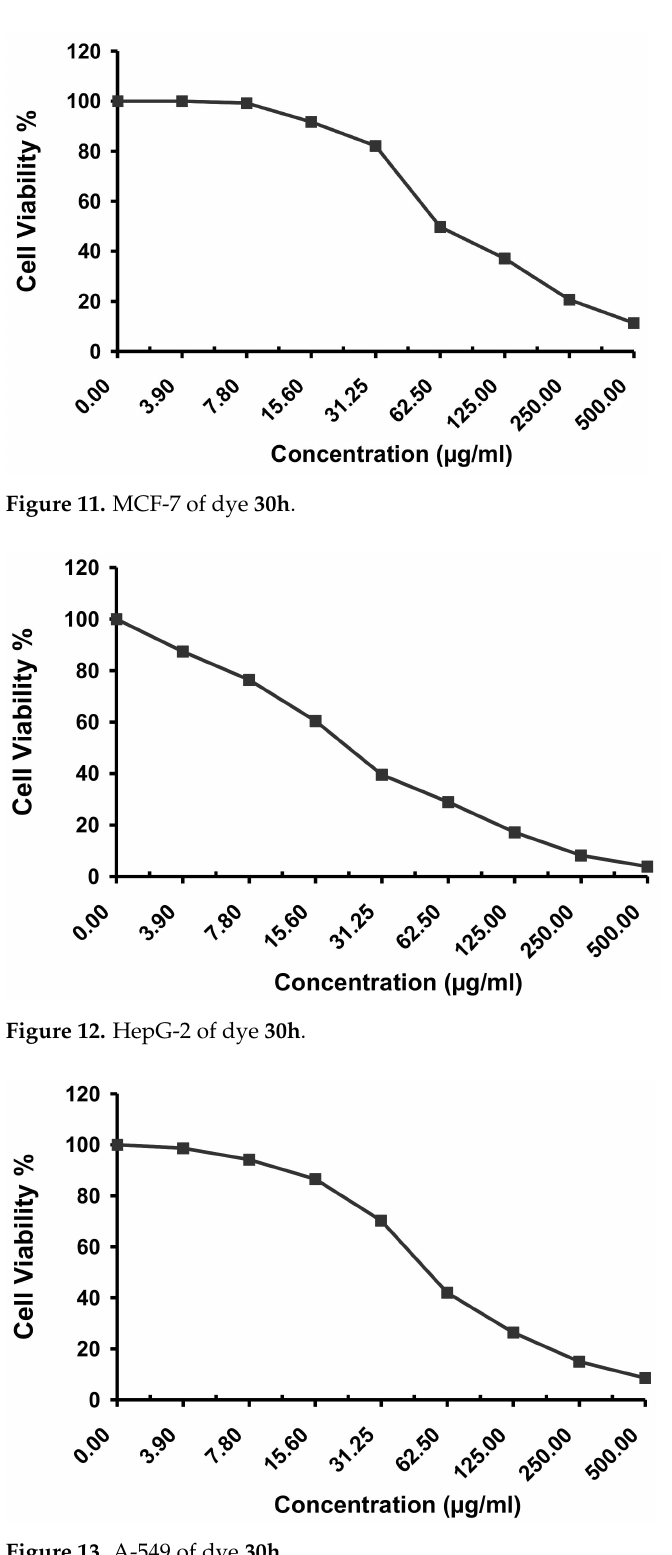
Figure 13. A-549 of dye 30h